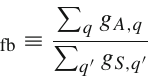
Fig. 12 The symmetric parton luminosities L S , q ( x 1 , m (cid:2) ¯ (cid:2) ) for the NNPDF4.0, ABMP16, CT18, and MSHT20 NNLO PDF sets for dilep- ton invariant masses of m (cid:2) ¯ (cid:2) = 5 TeV. The luminosities are multiplied by the effective charges S q defined in Eq. (2.8). From left to right, we